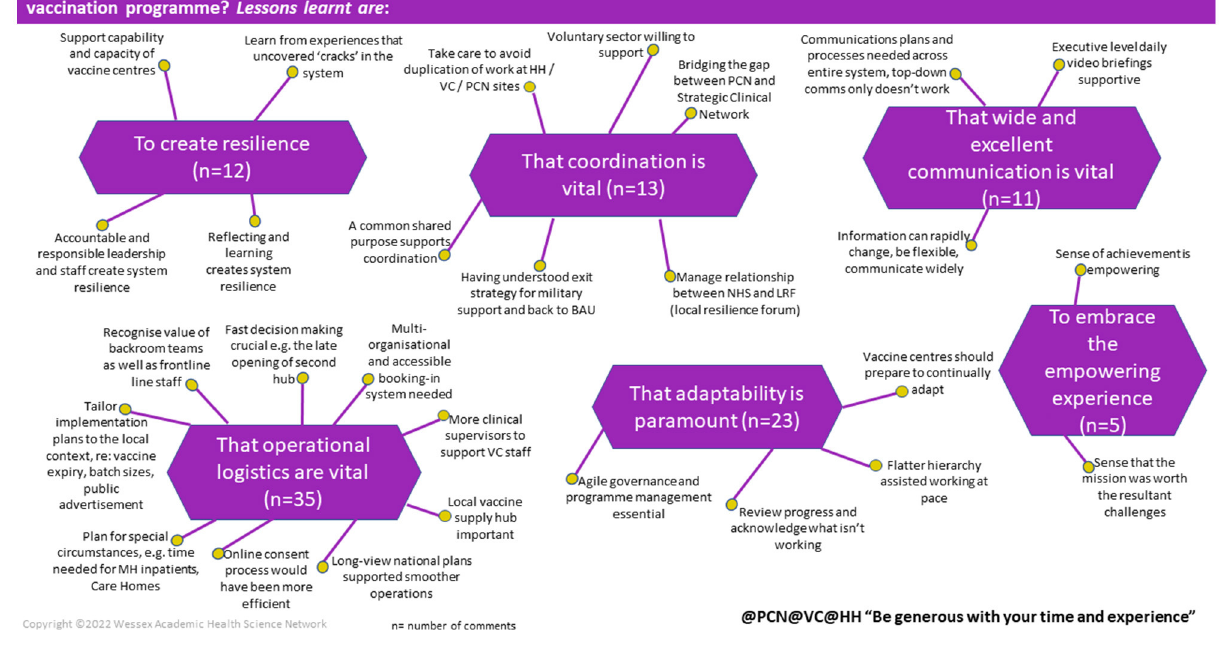
FIGURE2 Example of mind map. Extracted and modified from RI Report: NHS England—South west region rapid insight and learning from the COVID-19 mass vaccination programme, Wessex AHSN, April